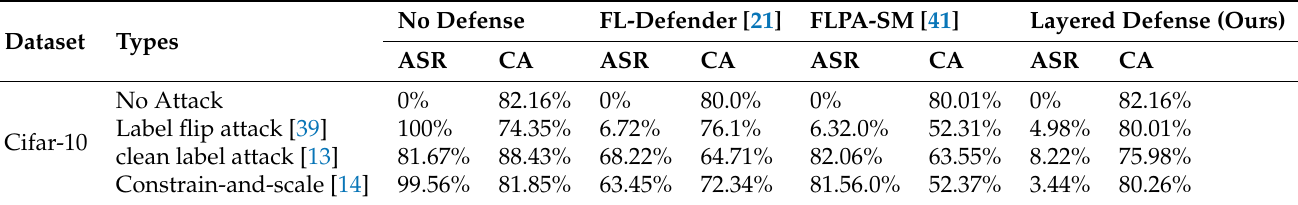
Table 2. The attack success rate (ASR%) and clean accuracy rate (CA%) of three backdoor defense methods against seven backdoor attacks, including Label flip attacks, clean label backdoor attacks, Constrain-and-scale. None means the training data are completely